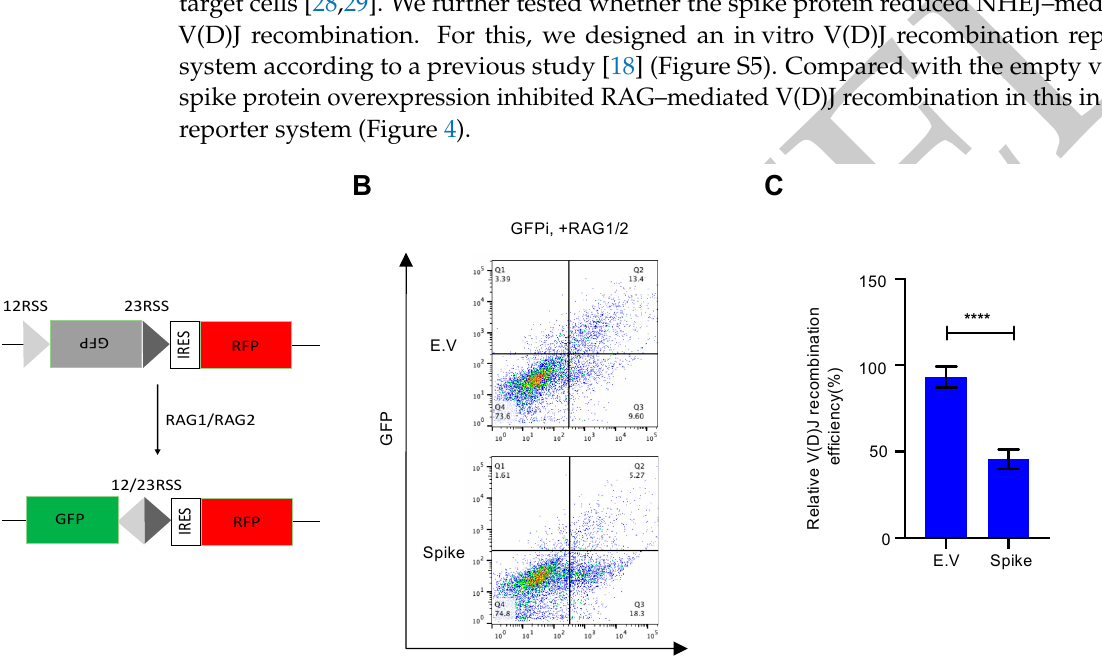
Figure 4. Spike protein impairs V(D)J recombination in vitro. ( A ) Schematic of the V(D)J reporter system. ( B ) Representative plots of flow cytometry show that the SARS–CoV–2 spike protein impedes V(D)J recombination in vitro. ( C ) Quantitative analysis of relative V(D)J recombination. The values represent the mean ± SD, n = 3. Statistical significance was determined using Student’s t -test. **** p < 0.0001.